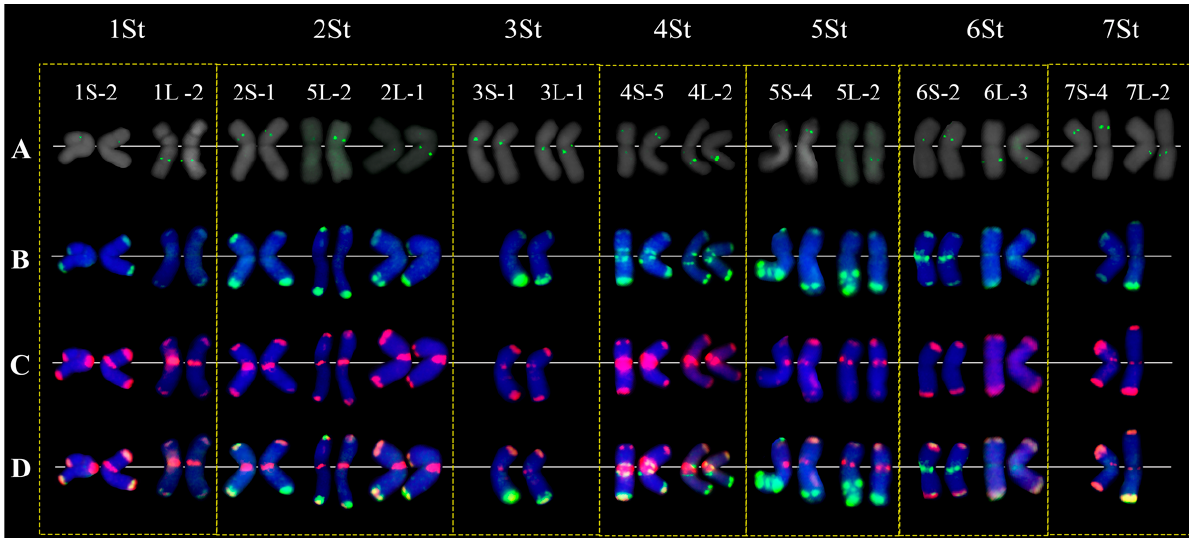
Figure 4. The distribution of STlib_96 + STlib_98 (green) and STlib_117 (red) after single ‐ gene probes in P. libanotica PI 228392. ( A – D ) Cytogenetic karyotype of P. libanotica with 14 single ‐ gene probes and developed repetitive sequences. ( A ) Single ‐ gene probe in green. ( B ) Repetitive sequence STlib_96 + Stlib_98 (green). ( C ) Repetitive cluster STlib_117 (red). S and L letters refer to short and long arms, respectively. ( D ) Merged repetitive clusters from STlib_96 + Stlib_98 (green) and STlib_117 (red).